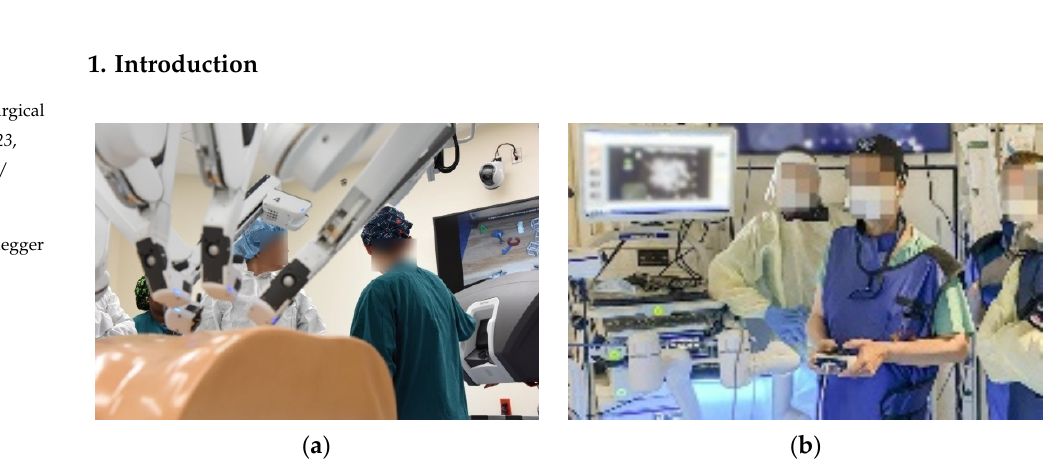
Figure 1. ( a ) Air Force surgeon receives a briefing from a nurse on robotic surgery capabilities inside the robotics surgery clinic at Keesler Medical Center, Miss., June 16, 2017 [1]. ( b ) VA Medical Center uses new Thoracic Oncology robotic arm to diagnose lung cancer in veterans [2]. U.S. Department of Defense photographs and imagery, unless otherwise noted, are in the public domain [3]. Images courtesy U.S. Department of Defense [4].